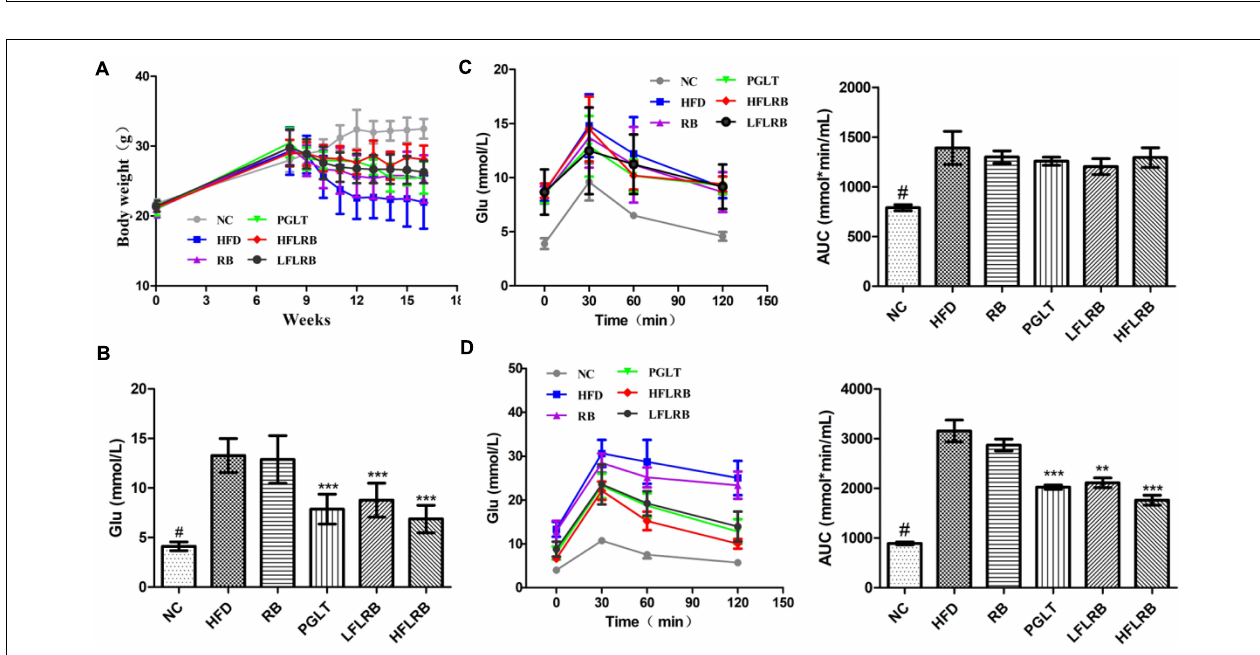
FIGURE 2 | Effects of FLRB on body weight and insulin resistance. Diabetic mice were treated with FLRB (1.0 and 0.5 g/kg), pioglitazone (PGLT) (10 mg/kg) and RB (1.0 g/kg) for 8 weeks. (A) Effect of body weight; (B) effect of blood glucose; (C,D) results of the Oral glucose tolerance test (OGTT) at the 8th and 16th weeks. Values are expressed as the mean ± SD ( n = 10). # and *** represent P < 0.001, ** represents P < 0.01, compared to the high-fat diet (HFD).